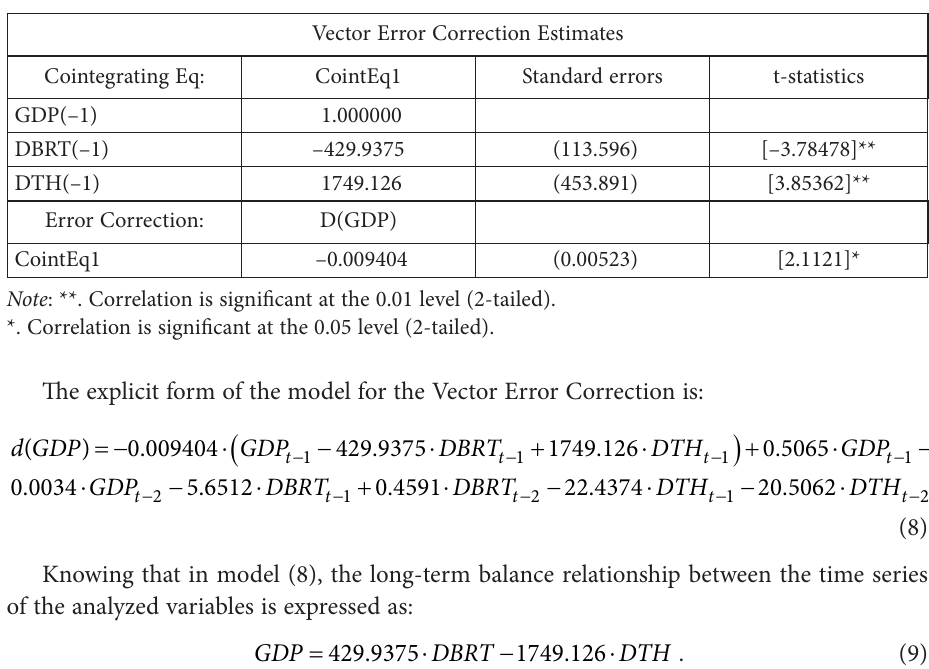
Table 12. Estimation and validation of the parameters of the cointegration model for Cluster B